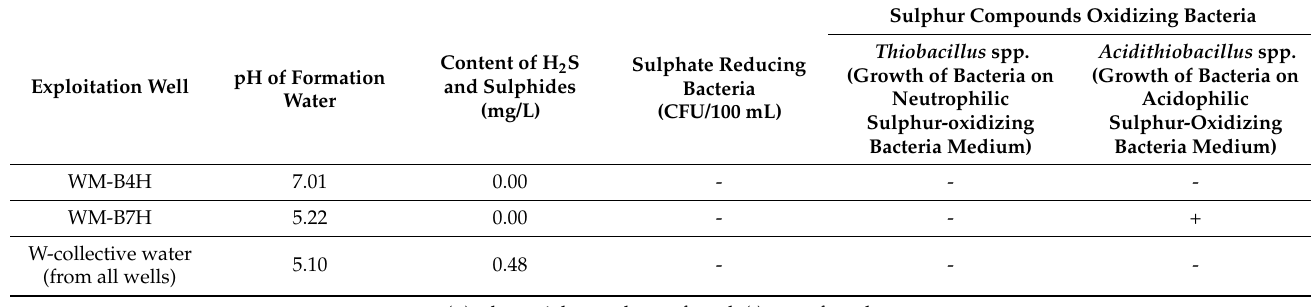
Table 1. The results of microbiological and chemical tests on formation waters collected from Wierzchowice UGS wells—XXII operational cycle (2016/2017).